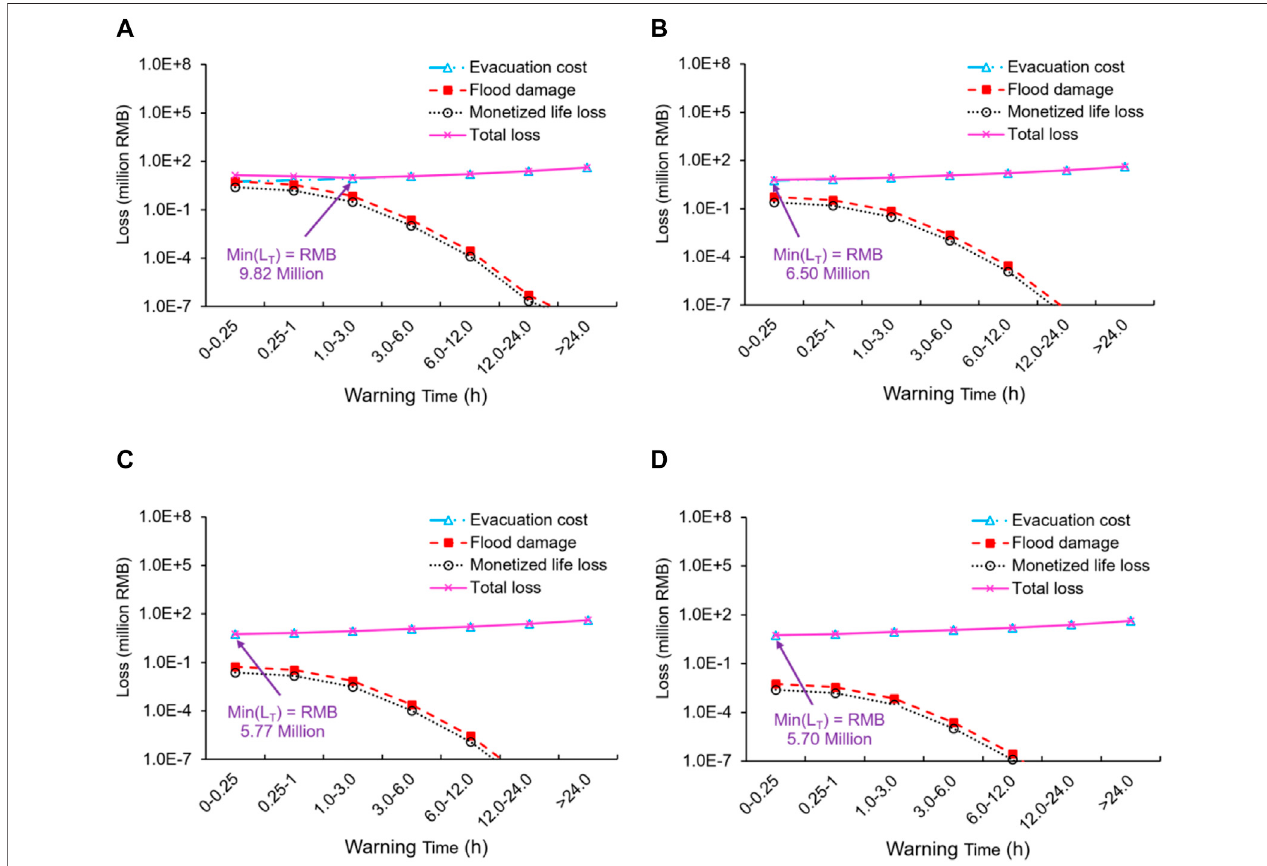
FIGURE 13 | The three types of losses and the total loss in Scenario 2 in Mianyang City with different W t : (A) P f (cid:2) 1; (B) P f (cid:2) 0.1; (C) P f (cid:2) 0.01; (D) P f (cid:2) 0.001.